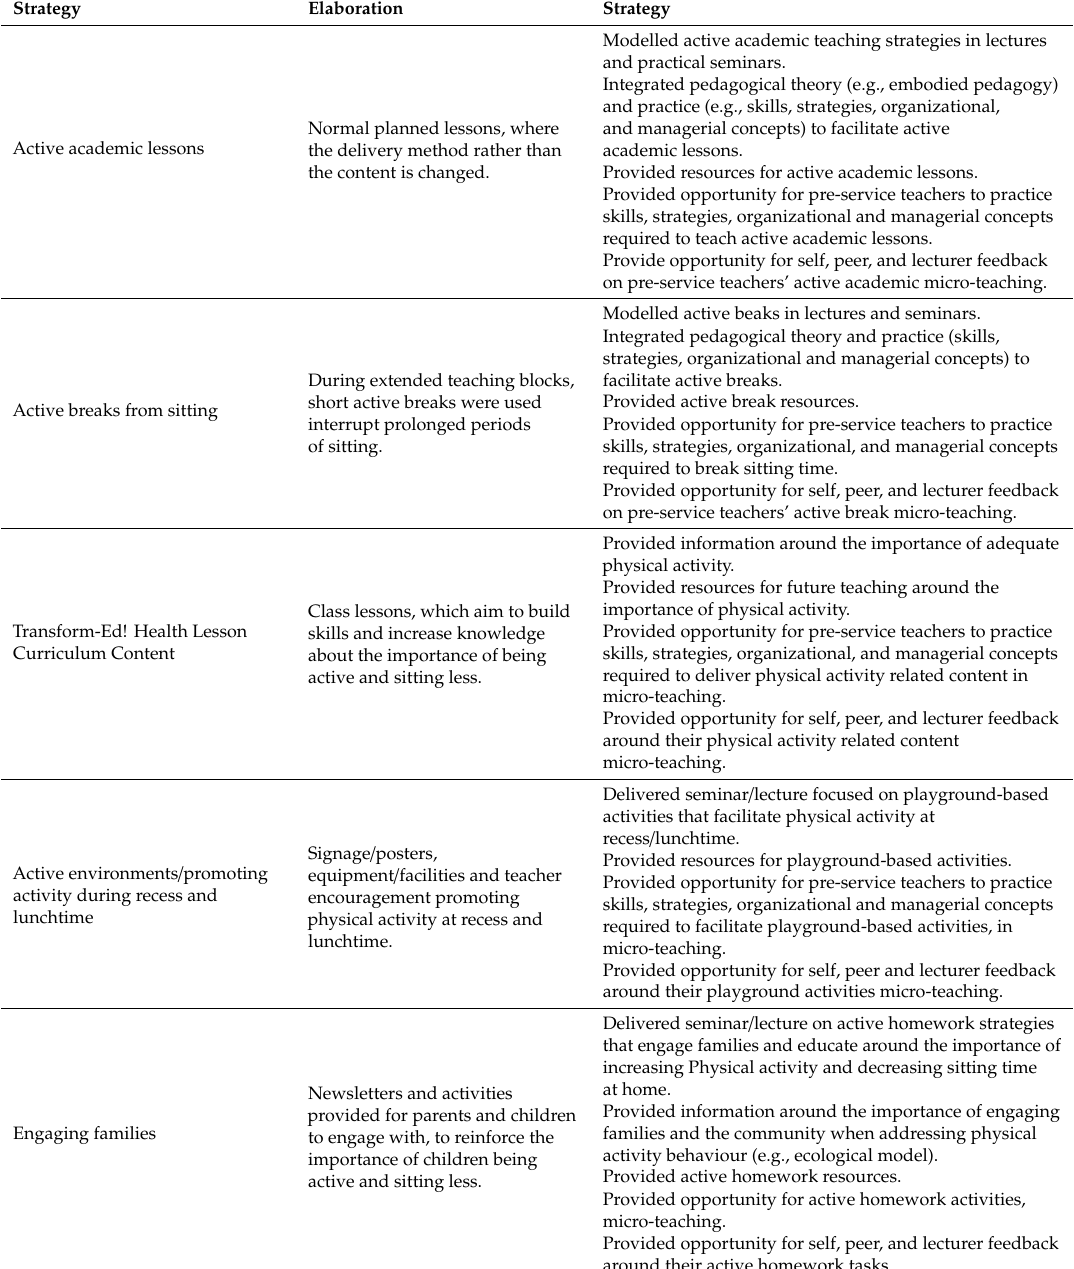
Table 1. Lecturer-to-pre-service teacher implementation